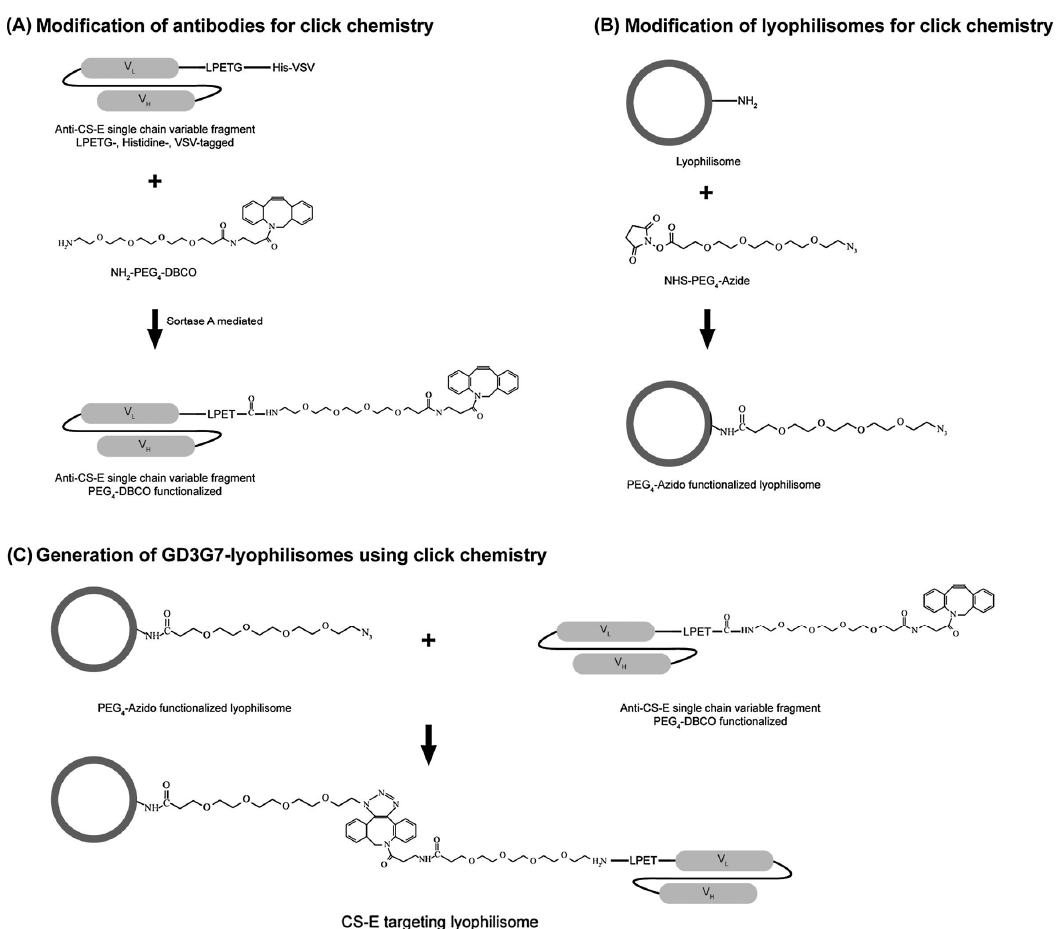
Figure 5. Construction of cancer targeting lyophilisomes depicting conjugation between albumin-based lyophilisomes and GD3G7 antibodies reactive with CS-E, by applying a two-step approach comprising sortase mediated ligation and click chemistry. ( A ) LPETG-His-VSV tagged single chain GD3G7 antibodies were modified for click chemistry by introducing amino-PEG4-DBCO through a reaction mediated by Sortase A. ( B ) Lyophilisomes were functionalized for click chemistry by conjugating PEG4-azide to the primary amine groups of lyophilisomes mediated by N -hydroxysuccinimide (NHS). ( C ) Antibody-functionalized lyophilisomes were generated by a click reaction between azido-conjugated lyophilisomes and GD3G7-PEG4-DBCO antibodies. Abbreviations: CS-E, chondroitin sulphate E; DBCO, dibenzylcyclooctyne; VL, light chain variable domain; VH, heavy chain variable domain; SrtA, Sortase A. (Reprinted from [126] with permission from Elsevier)